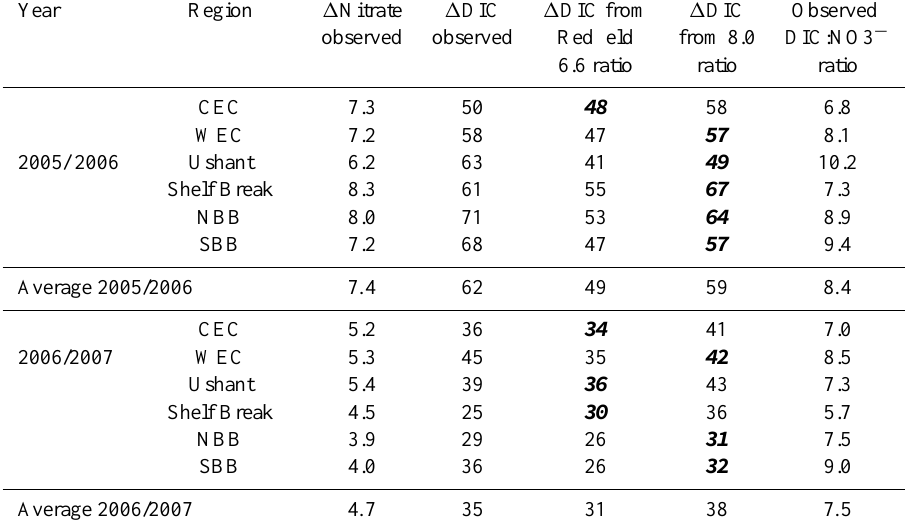
Year Region 1 Nitrate 1 DIC 1 DIC from 1 DIC Observed observed observed Redfield from 8.0 DIC:NO3